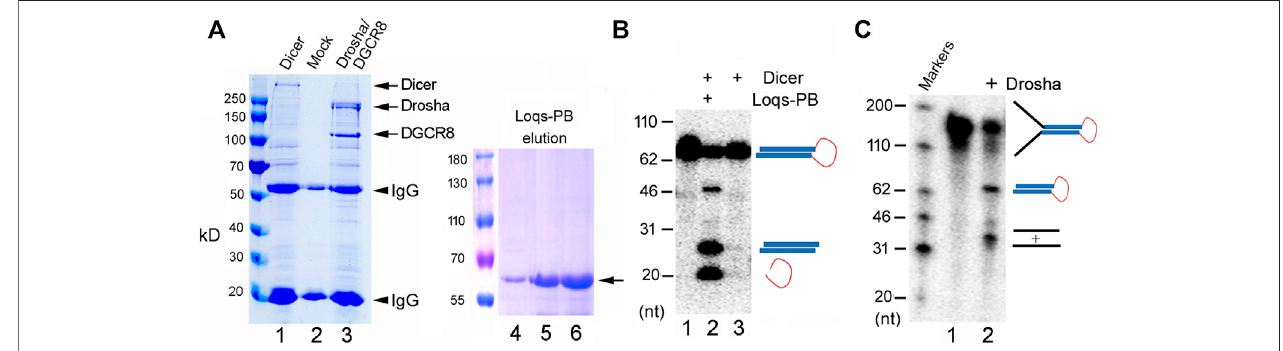
FIGURE 1 | Puri fi cation and activity assays of the fruit fl y miRNA processing enzymes. (A) Puri fi cation of recombinant Dicer, Drosha/DGCR8 from transfected 293T cells (lanes 1 – 3) and Loqs-PB from overexpressing bacteria (lanes 4 – 6). 293T cells were transfectd with plasmids expressing the FLAG-tagged Dicer or FLAG- tagged Drosha and Myc-tagged DGCR8. Following immunoprecipitation with an anti-FLAG antibody, proteins were detected by gel electrophoresis and Coomassie staining. Lane 1: The immunoprecipitate of FLAG-Dicer; lane 2: immunoprecipitate from mock-transfected cells; lane 3: immunoprecipitate of FLAG-Drosha and Myc-DGCR8;lanes4 – 6:differentelutionfractionsofHis-tagged Loqs-PBafter nicklebeads puri fi cation. Arrows pointstotheexpected fruit fl y proteins, andarrowheads the IgG heavy and light chains. Protein markers (in kilodaltons, kD) are indicated on the left. (B) Dicer activity assay. The 32 P-labeled dme-pre-miR-375 was incubated with Dicer alone or together with Loqs-PB at 37 ° C for 30 min, fractionated on a 12% denaturing gel, and analyzed by phosphorimaging. DNA markers with size of the individualbandsinnucleotide(nt)areindicatedontheleft,andschematicsofthesubstrateandcleavageproductsshownontheright. (C)